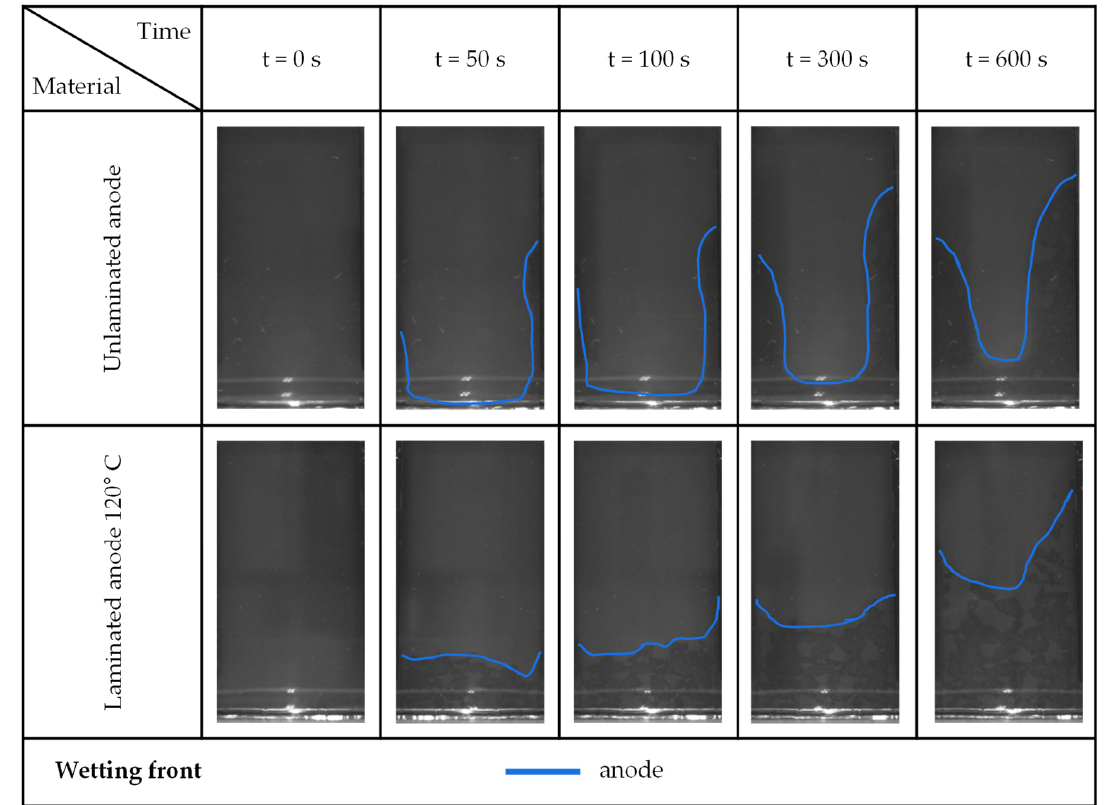
Figure A3. Images of the optical measurement of the anode separator measurement series at four time points. The shape and height of the wetted visible surface are shown. Start of the measurement at t = 0 s.